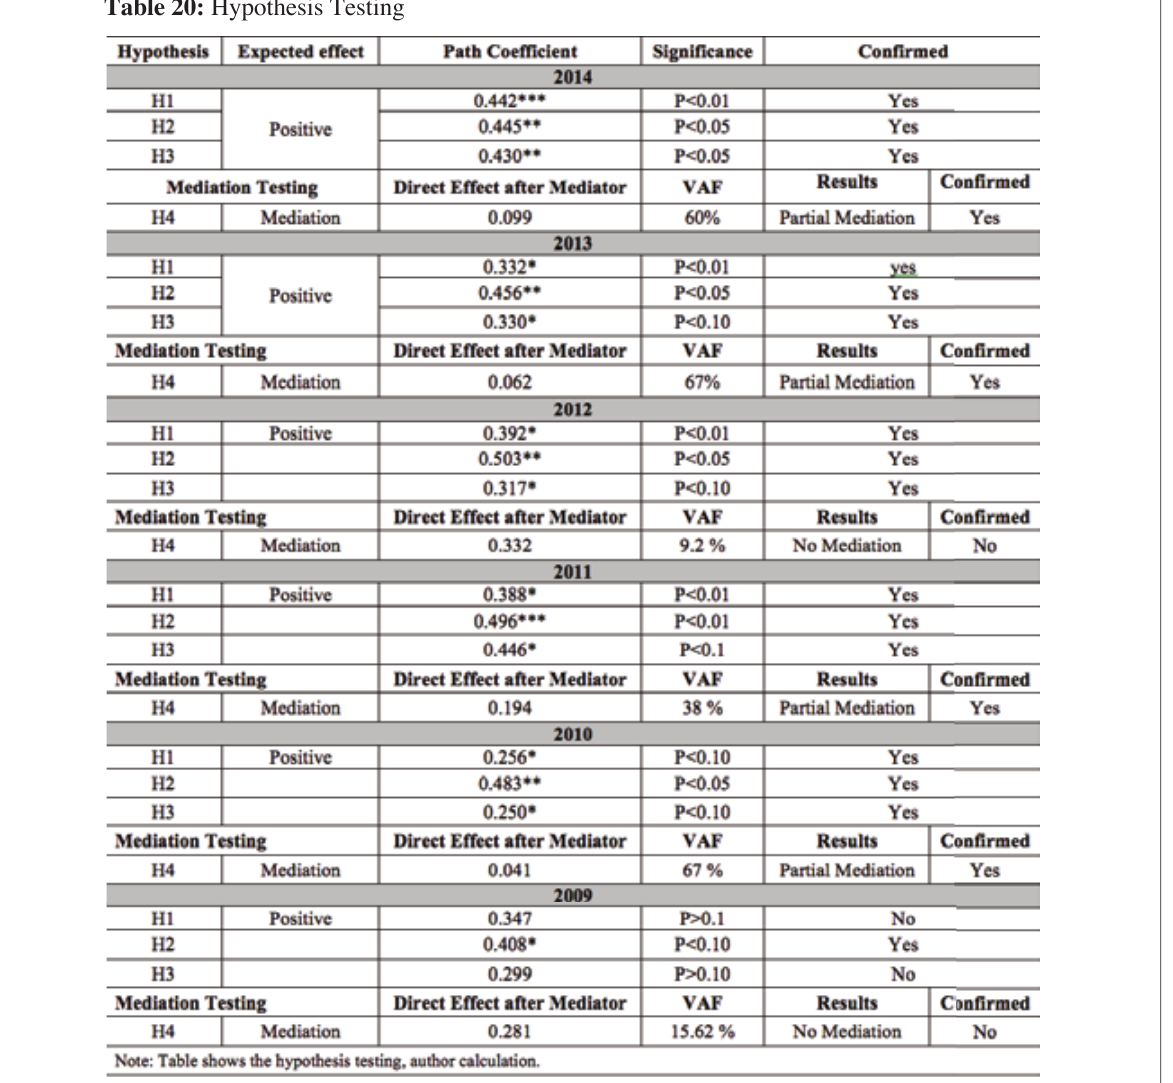
Table 20: Hypothesis